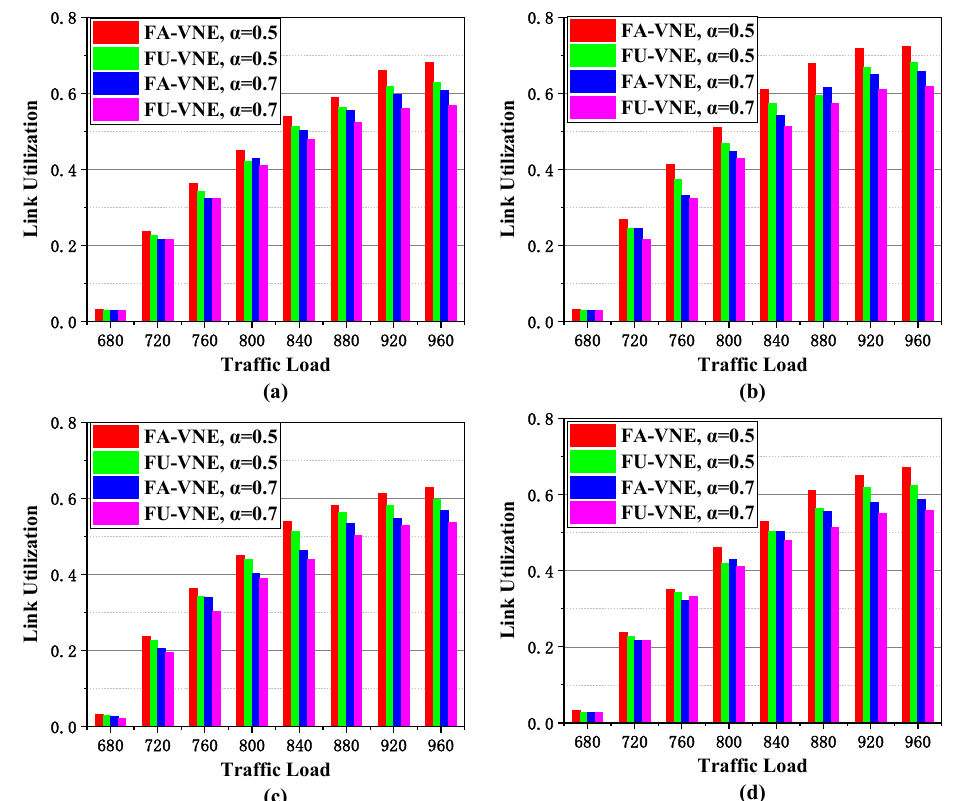
Figure 5. Simulation and results: ( a ) LUR under NS-A; ( b ) LUR under NS-B; ( c ) LUR under NS-C; and ( d ) LUR under NS- D.